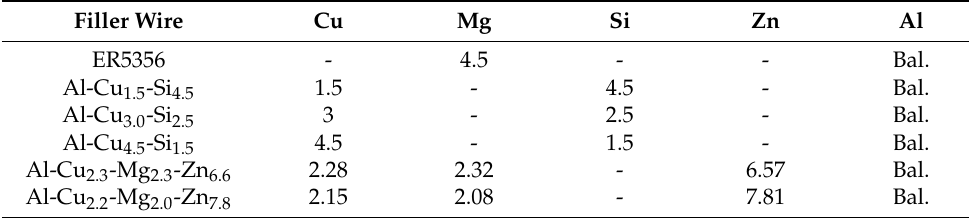
Table 1. Chemical composition of filler and base metal (wt.%). Filler Wire Cu Mg Si Zn